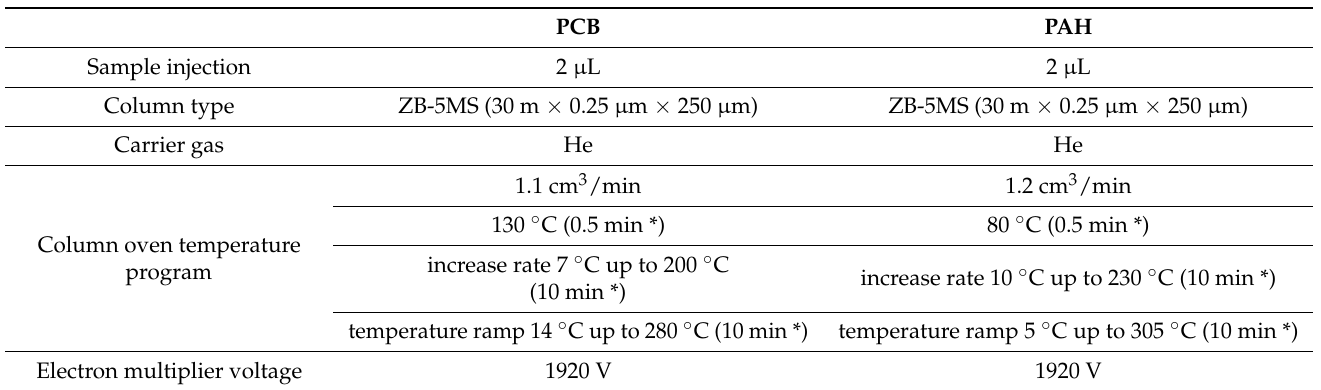
Table 2. Chromatographic separation